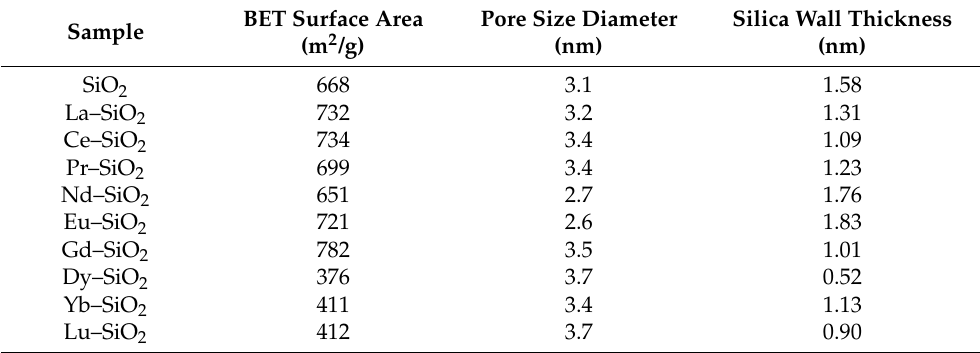
Table 5. Structural properties of calcined materials of surface area, pore size diameter and silica wall thickness.